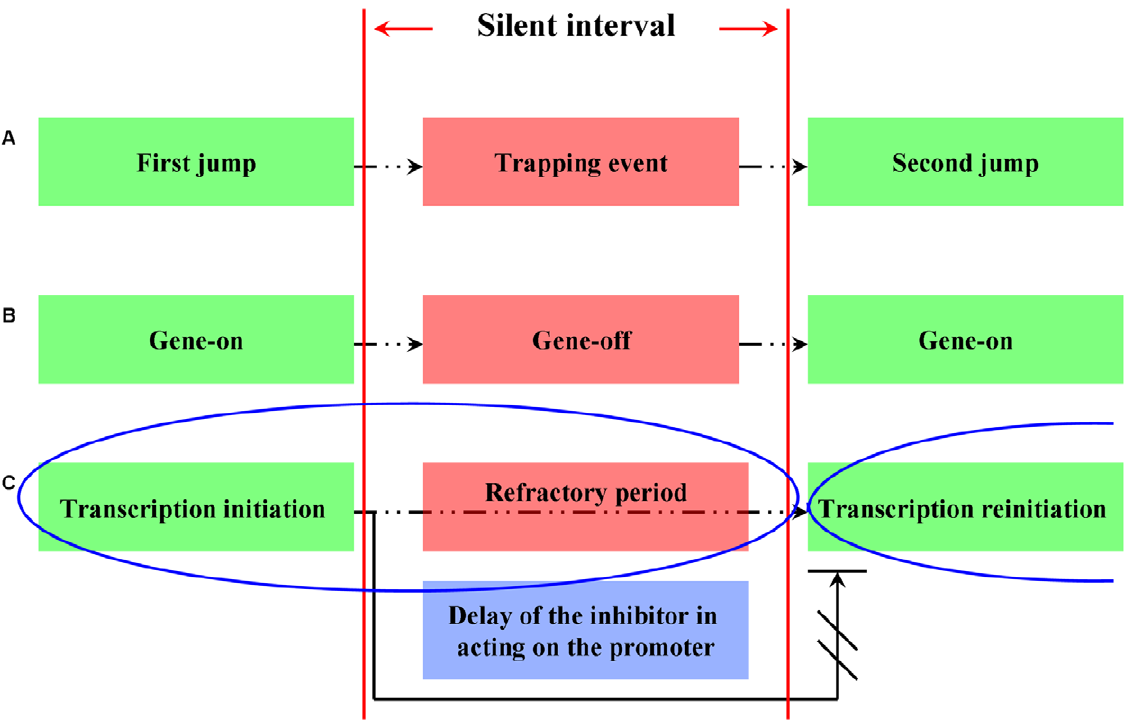
Figure 2. Consecutive events are separated by a silent interval. A. Inserting a trapping event into two neighboring jumps of the Brown particle in the continuous time random walk. B. The silent interval corresponds to the gene-off state. C. Temporally discontinuous transcription. The reinitiation will not launch until the refractory period is over, then the inhibitor starts to act on the promoter and triggers the reinitiation. Therefore, the time span of the silent interval can be treated to be equal to the time delay of the inhibitor generated in last transcriptional event. The blue ellipse indicates an intact transcriptional event.